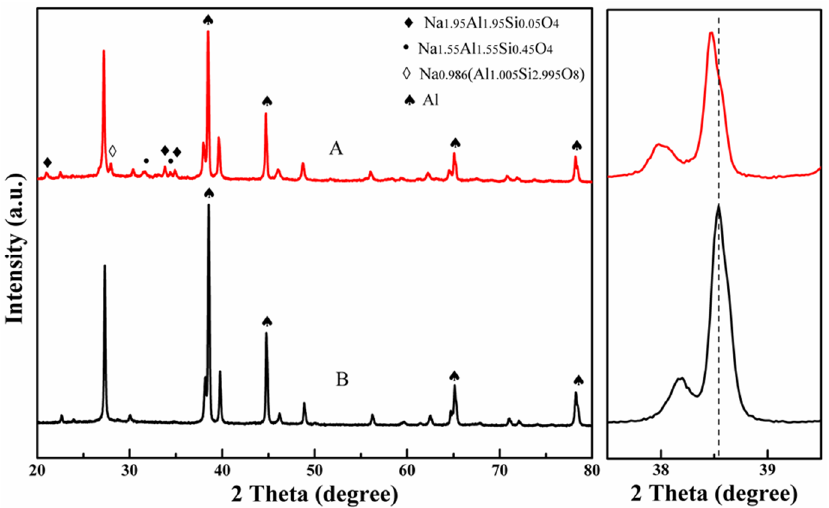
Figure 6. XRD patterns of samples with and without sodium carbonate. A: Sample with sodium carbonate added; B: Sample without sodium carbonate added.